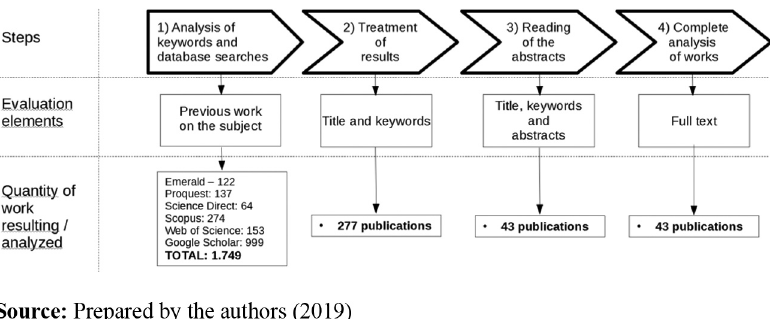
Figure 1. Flowchart with the research